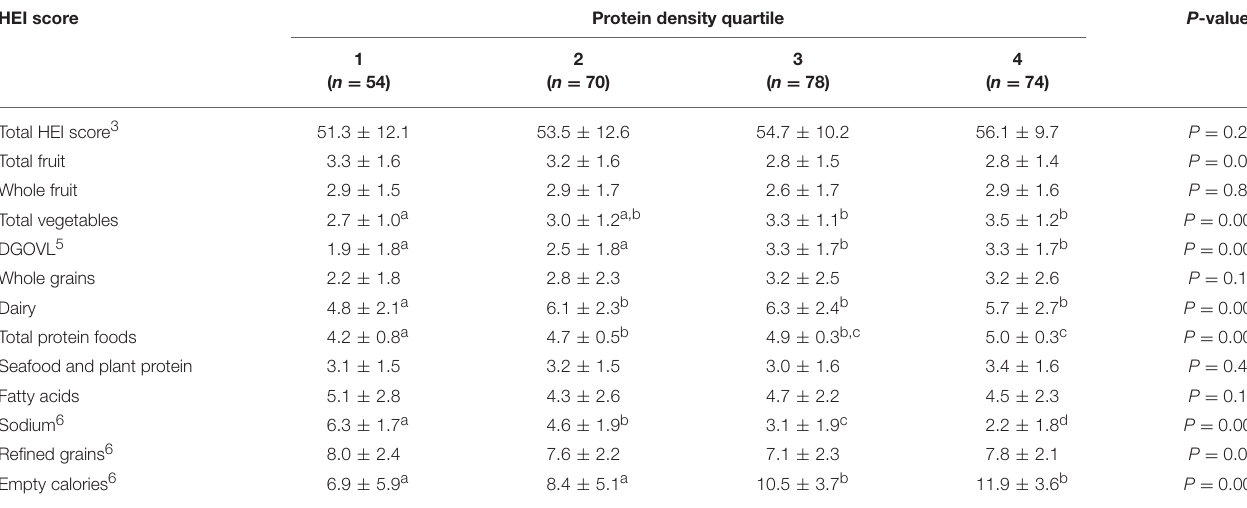
TABLE 2 | Healthy Eating Index (HEI) scores based on habitual protein intake in healthy young males 1, 2 . HEI score Protein density quartile